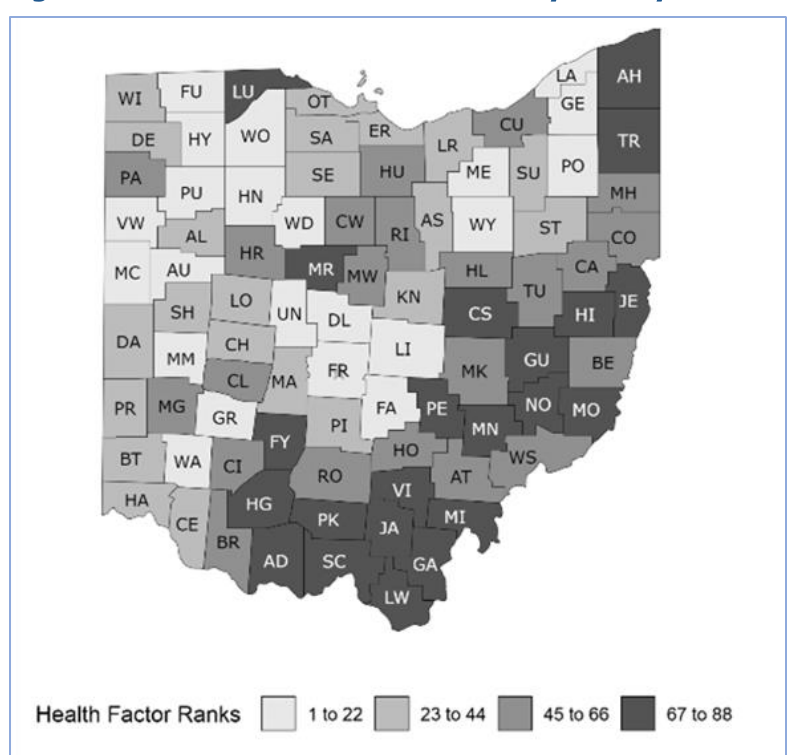
Figure 1. Health Factor Ranks in Ohio by County in 2021